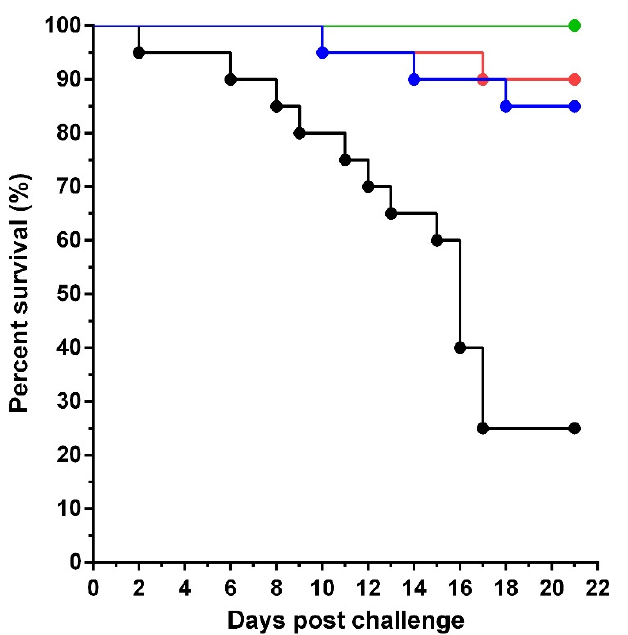
Figure 3. Average percent survival of Nile tilapia juveniles passively immunized with pooled sera from female broodstock by intramuscular injection (IM) and then challenged with TiLV TH-2018 at 9 × 10 5 TCID 50 per fish. The differences were statically significant between group 1, 2, 4 and group 3 ( n = 20 per group, Log Rank test: p < 0.0001). HKV, FKV, and control mean broodstock fish were immunized with heat-killed vaccine, formalin-killed vaccine and L15 medium, respectively. The L15 group is negative control group treated with L15 medium without virus ( n = 20).